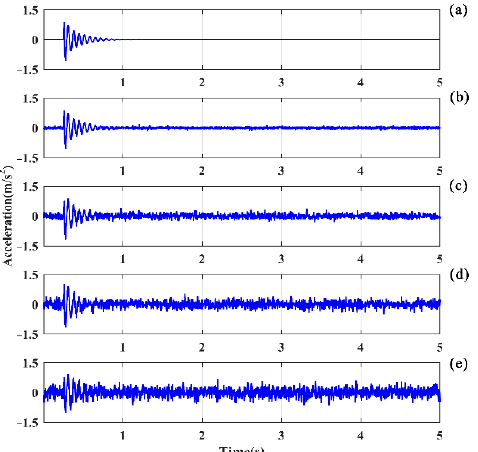
Figure 13. Frequency domain responses excited by different excitations: ( a ) beam 1; ( b ) beam 3.